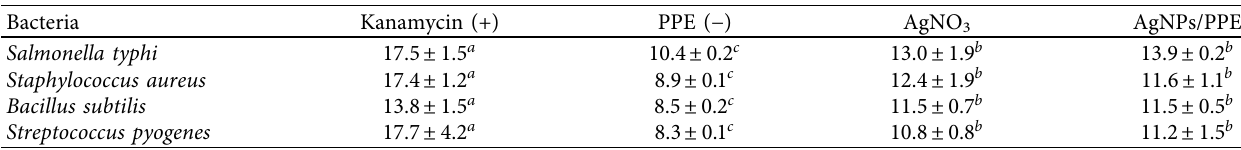
− ). 3 against four bacterial